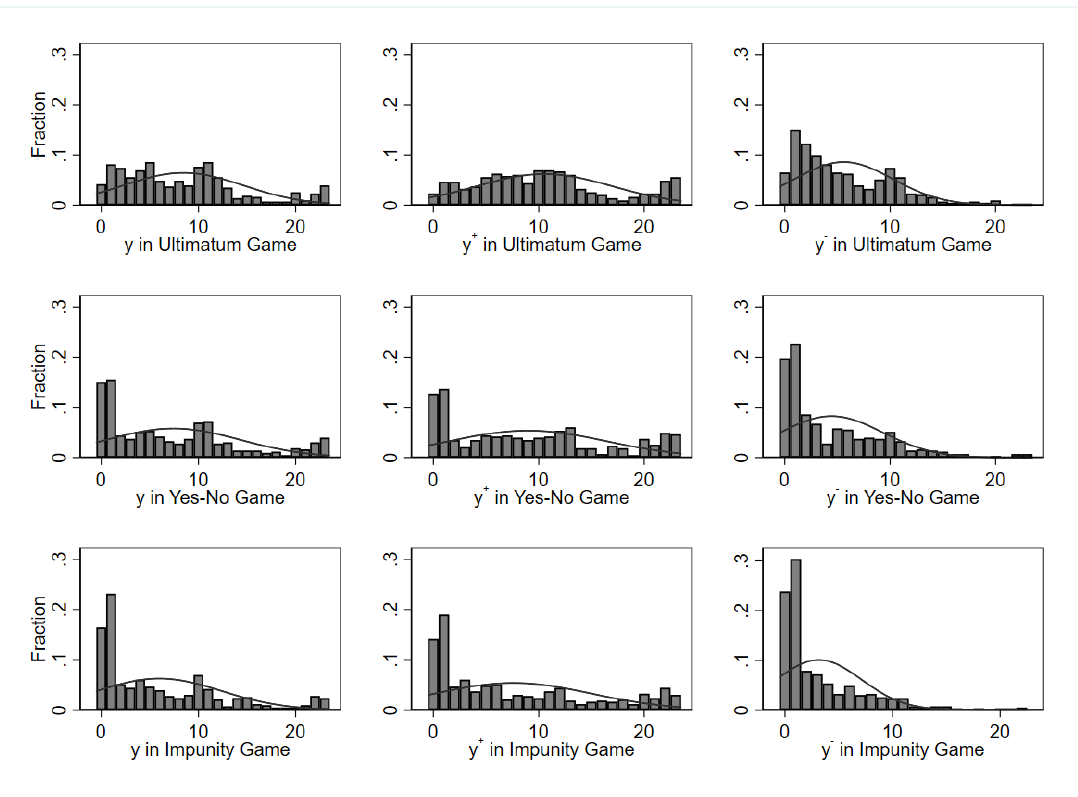
Figure 3. Fraction of offers y , y + , y − . Notes: The range of offer profiles is from 0 to 23 to encompass both odd and even offers. The graph encloses normal density curve for each